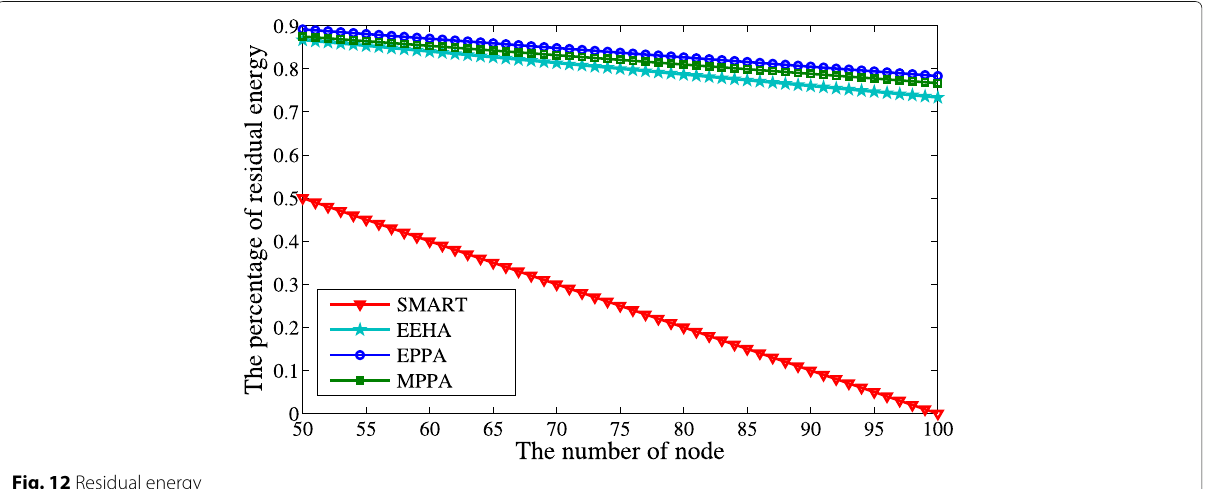
Fig. 12 Residual